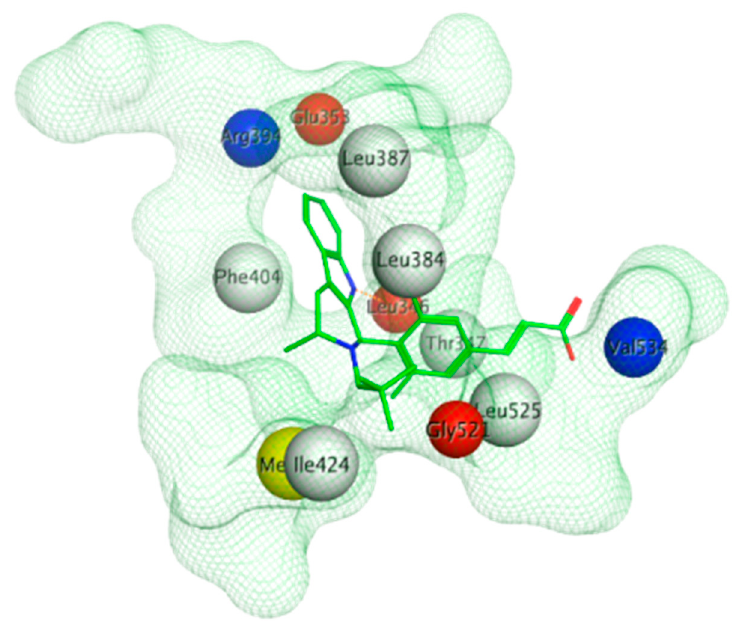
Figure 8. Site view of AZD9496 (green) in complex with ER α -EBS (pdb: 5ACC). The indole ring of AZD9496 forms a hydrogen bond (dashed, orange) with Leu346.